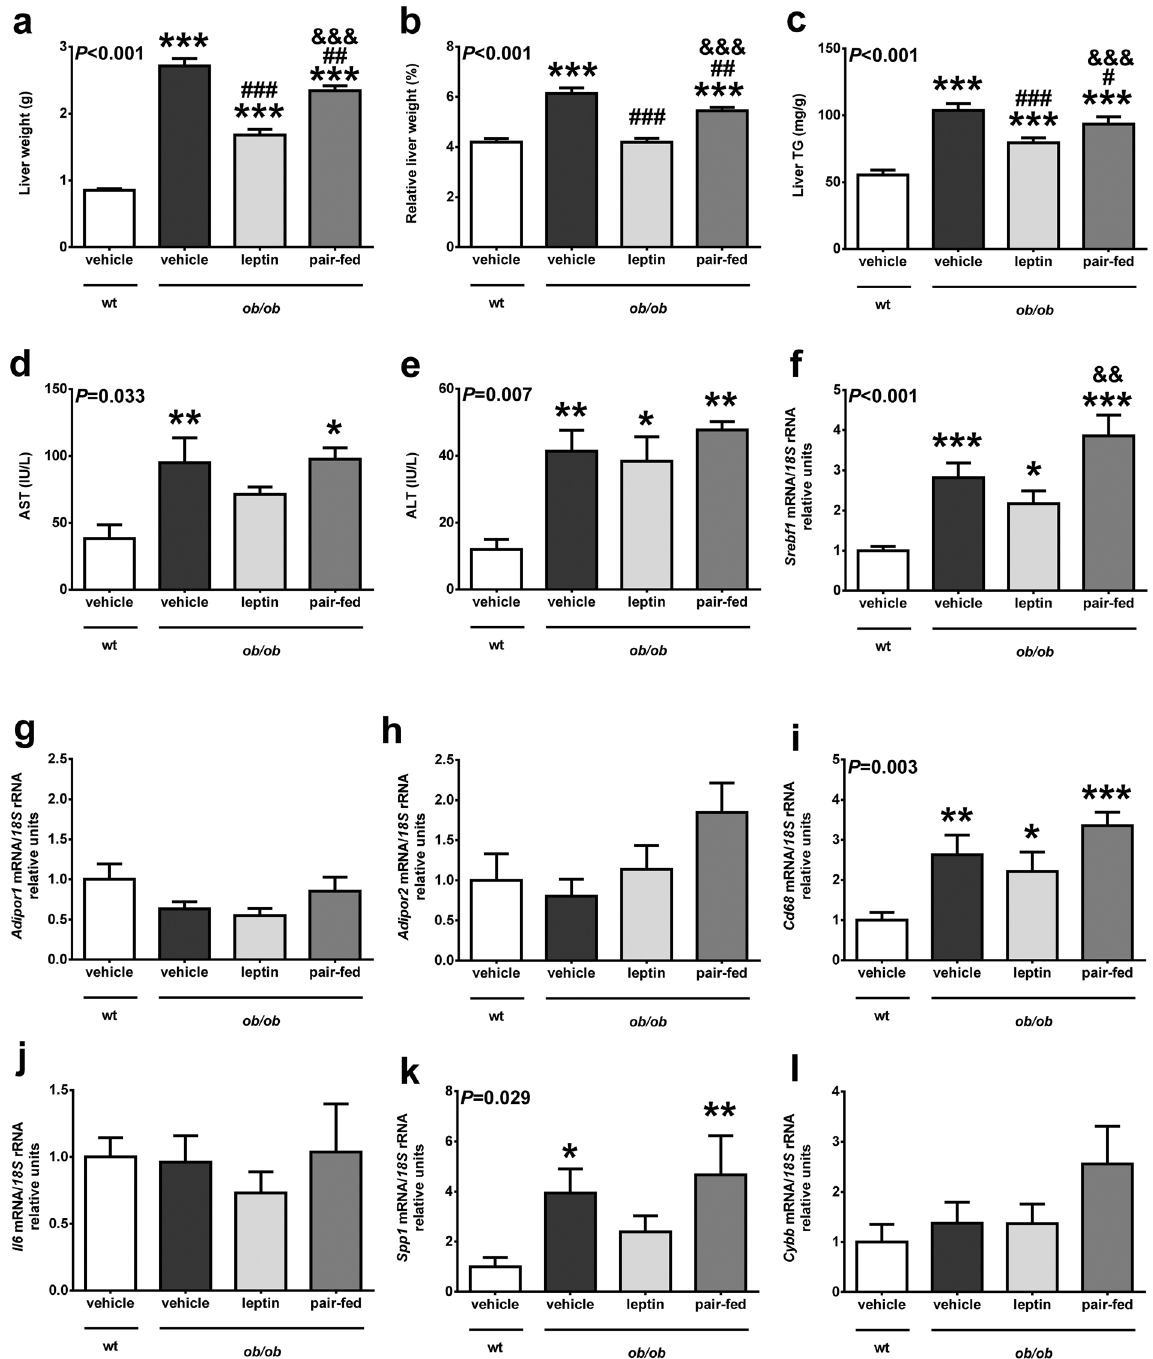
Figure 4. Leptin replacement in ob/ob mice reduces liver steatosis and regulates the expression of genes involved in inflammation. Liver weight ( a ), relative liver weight ( b ), triglyceride content in the liver ( c ) and serum AST ( d ) and ALT ( e ) levels of the animals from the different experimental groups. Mean ± SEM of 7–10 animals. ( f ) Expression of the lipogenic gene Srebf1 in the liver. Gene expression levels of Adipor1 ( g ), Adipor2 ( h ), Cd68 ( i ), Il6 ( j ), Spp1 ( k ) and Cybb ( l ) in the liver in wild type (wt) and ob/ob mice receiving vehicle, leptin or receiving vehicle and pair-fed to the leptin group. Data presented as mean ± SEM of 6–10 animals. Differences between groups were analyzed by one way ANOVA followed by LSD test. * P < 0.05, ** P < 0.01 and *** P < 0.001 vs wt; # P < 0.05, ## P < 0.01 and ### P < 0.001 vs ob/ob treated with vehicle; && P < 0.01 and &&& P < 0.001 vs ob/ob treated with